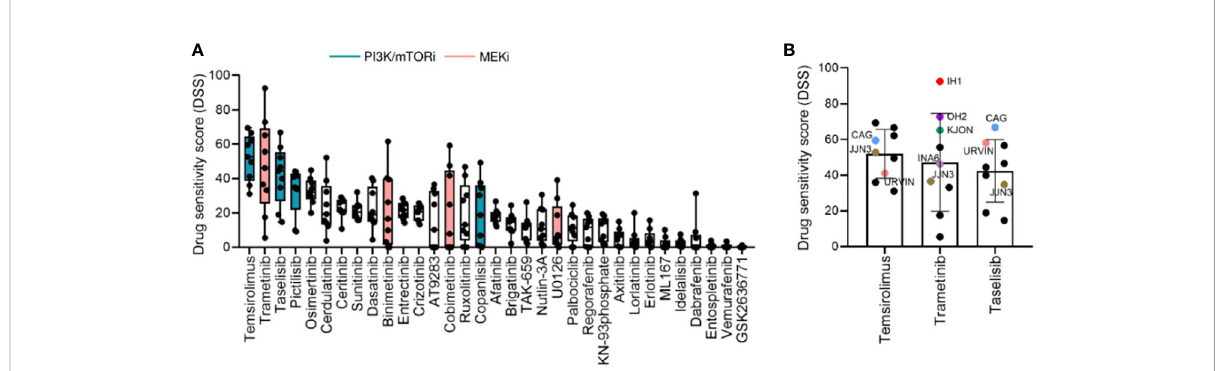
FIGURE 2 Drug sensitivity pro fi le in MM cell lines. (A) , Drug sensitivity to the indicated drugs across the 9 MM cell lines shown in Figure 1. The graph shows DSS for the indicated drugs sorted from most to least effective as mean ± SD. Green and pink bars indicate PI3K/mTOR inhibitors (PI3K/mTORi) and MEK inhibitors (MEKi), respectively. (B) , DSS distribution for the three most effective drugs (target indicated): temsirolimus (mTOR, PI3K, AKT), trametinib (MEK1/ 2 ), and taselisib (PI3K) inhibitors in the MM cell lines. MM cell lines with targeted mutations are indicated in different